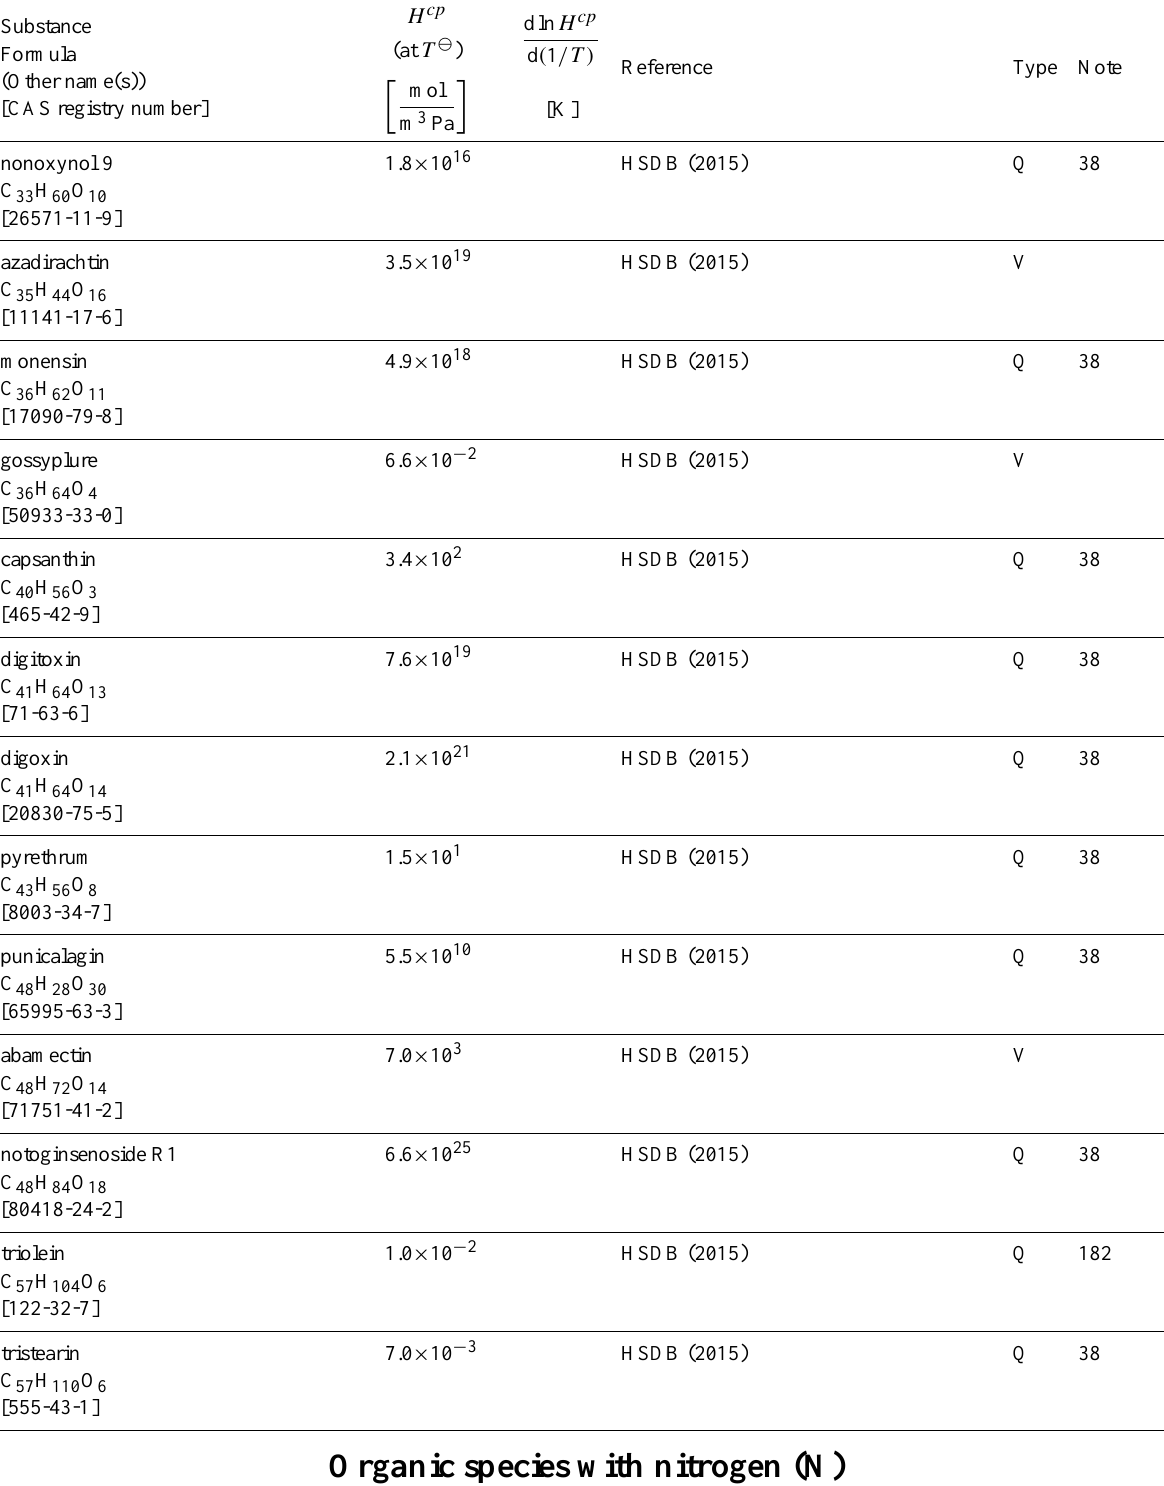
Table 6: Henry’s law constants for water as solvent